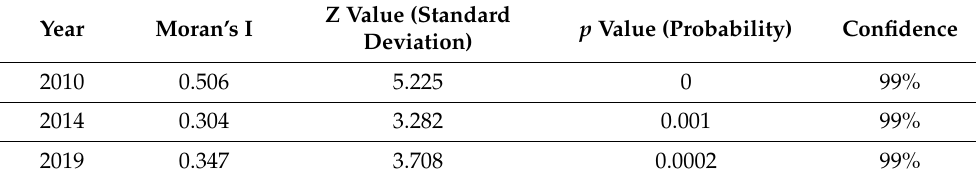
Table 6. Moran’s I value of coordination in Three Gorges Reservoir Area (Chongqing section).